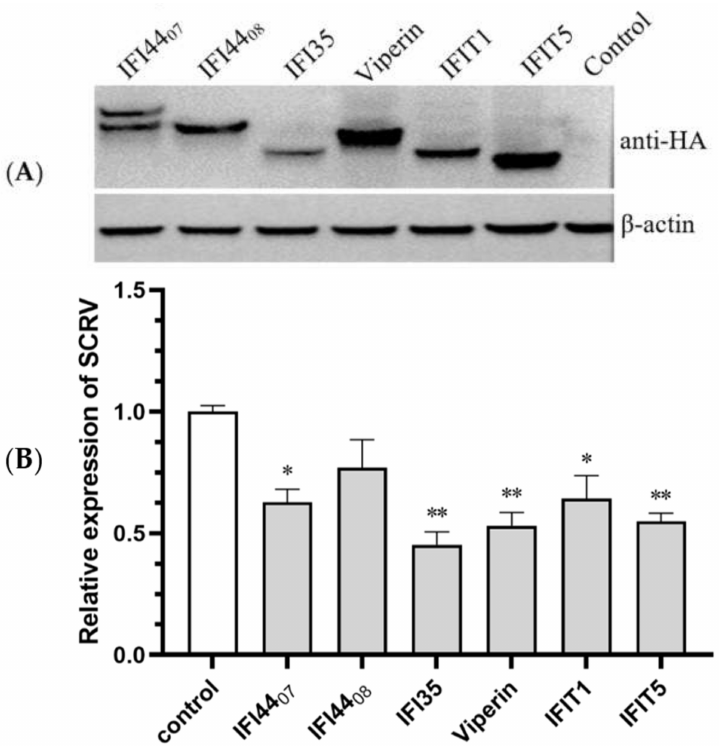
Figure 5. Antiviral effect of heterologously expressed ISGs on SCRV infection. ( A ) Western blot analysis of the expression of ISGs in FHM cells. The IFI44 07 , IFI44 08 , IFI35, Viperin, IFIT1, and IFIT5 of SCSC cells were successfully expressed in FHM cells. ( B ) RT-qPCR analysis of the expression of the SCRV gene in the ISGs expressed FHM cells. The expression level of the control was set as 1. * p < 0.05, ** p <